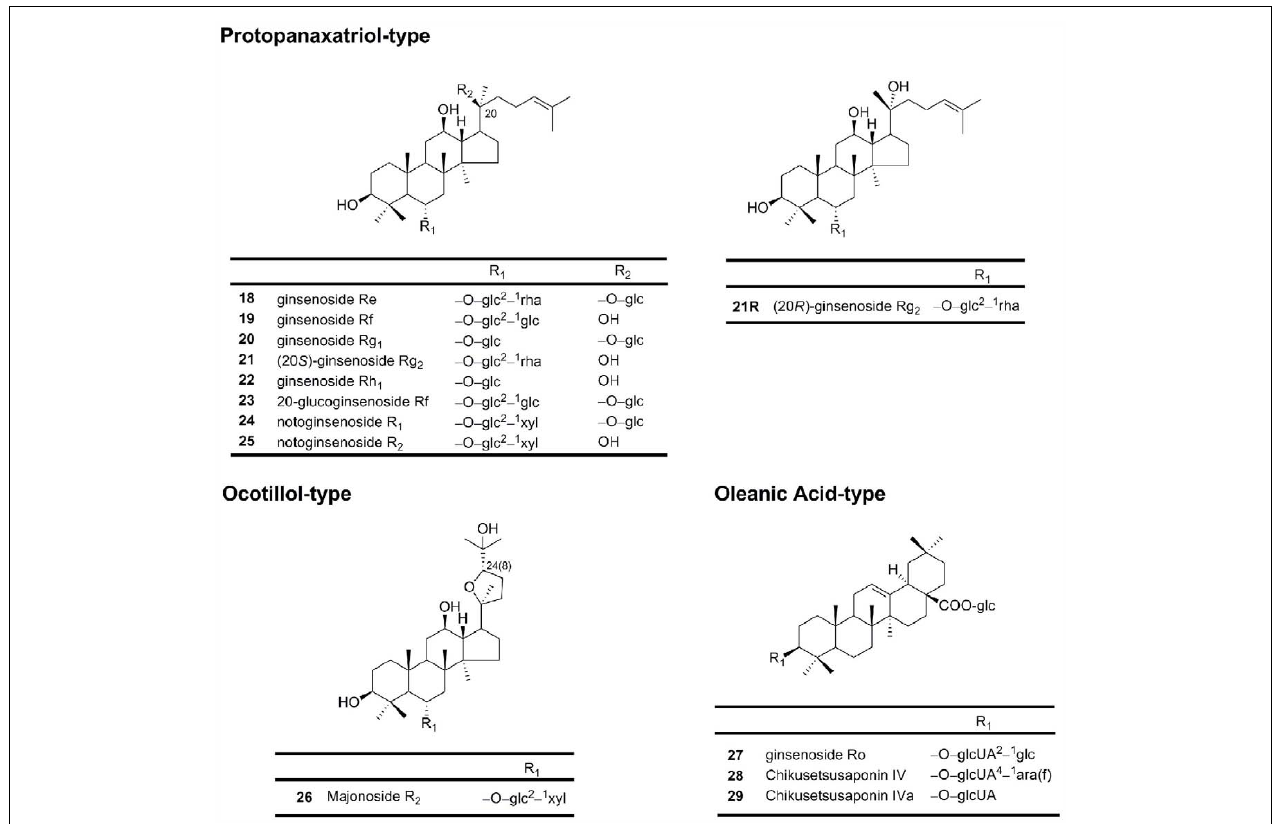
FIGURE 2 | Chemical structures of protopanaxatriol-type, ocotillol-type and oleanic acid-type